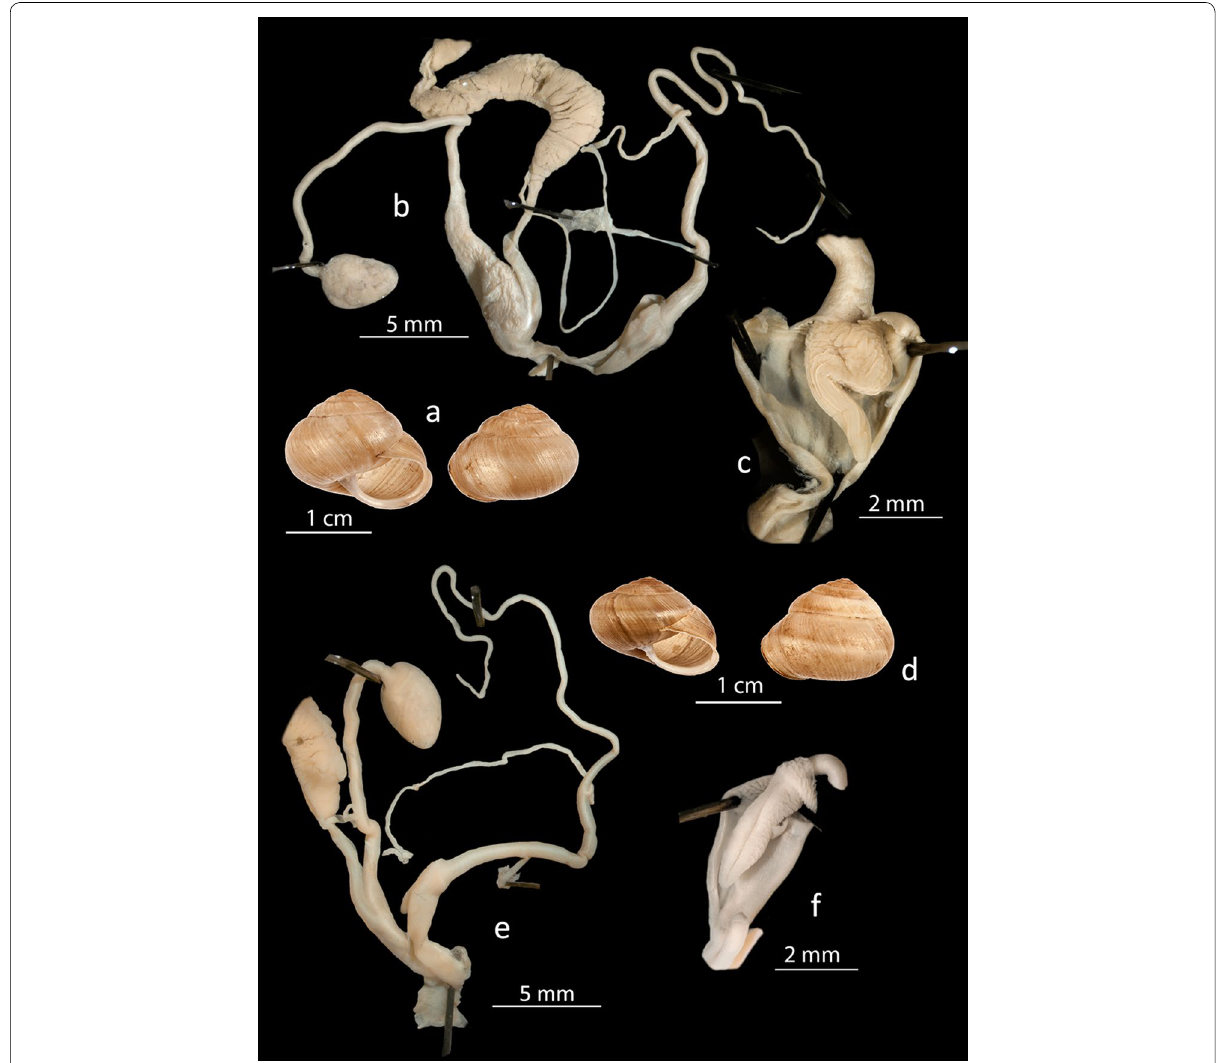
Fig. 3 Shell and genitalia of Metafruticicola schuberti ( a – c ) and Metafruticola rugosissima ( d – f ). M. schuberti a: shell; b genitalia; c penis papilla. M. rugosissima, d shell; e genitalia; f penis